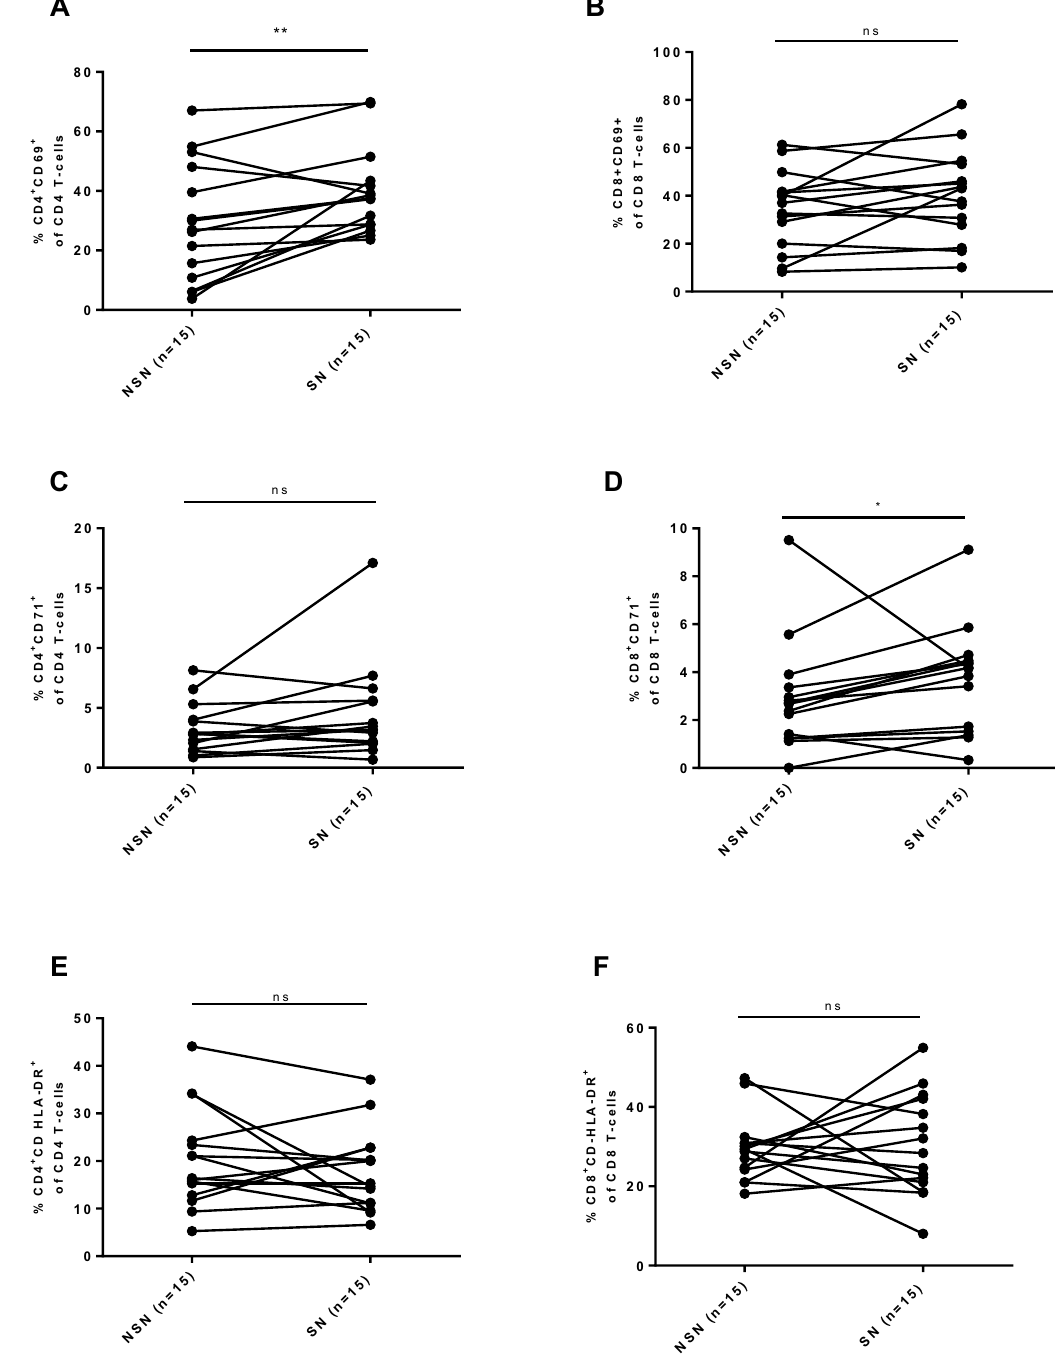
Figure 2. The percentage of activation surface antigens in non-sentinel nodes and sentinel nodes in OSCC patients. All the cases are paired and linked with a line. When more than one sentinel/non-sentinel node was obtained per patient, a mean value was calculated and included into presented analysis. ( A , B , E , F ) compared by paired t-test; ( C , D ) compared by Wilcoxon matched-pairs signed rank test. *< 0.05, **<